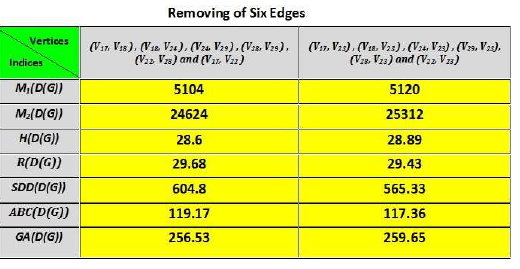
Fig. 7 Removing of six edge sets of healthy Liver